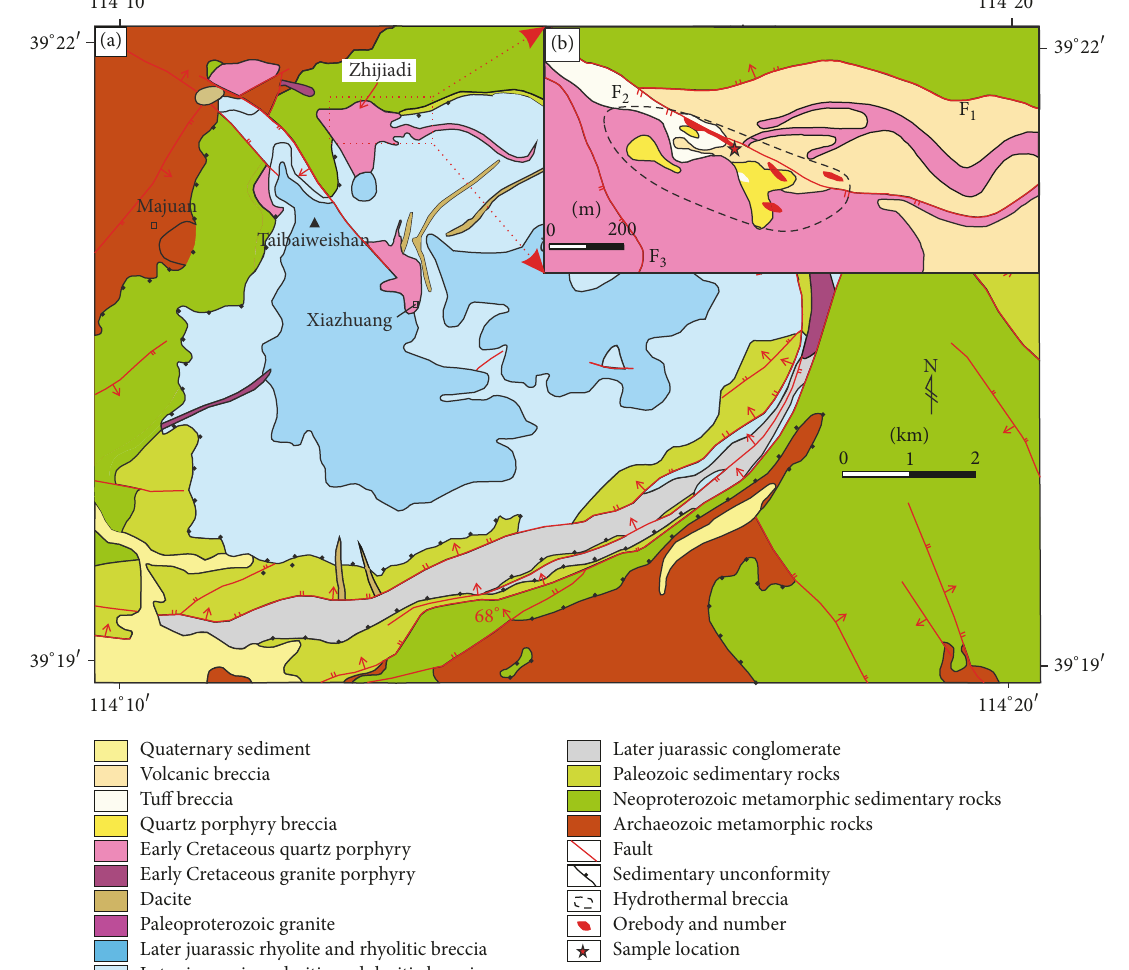
Figure 2: (a) Simplified geologic map (modified from unpublished internal map of the third geological exploration institute of China Metallurgical Geology Bureau). (b) The distribution of orebodies in the Zhijiadi deposit (modified from